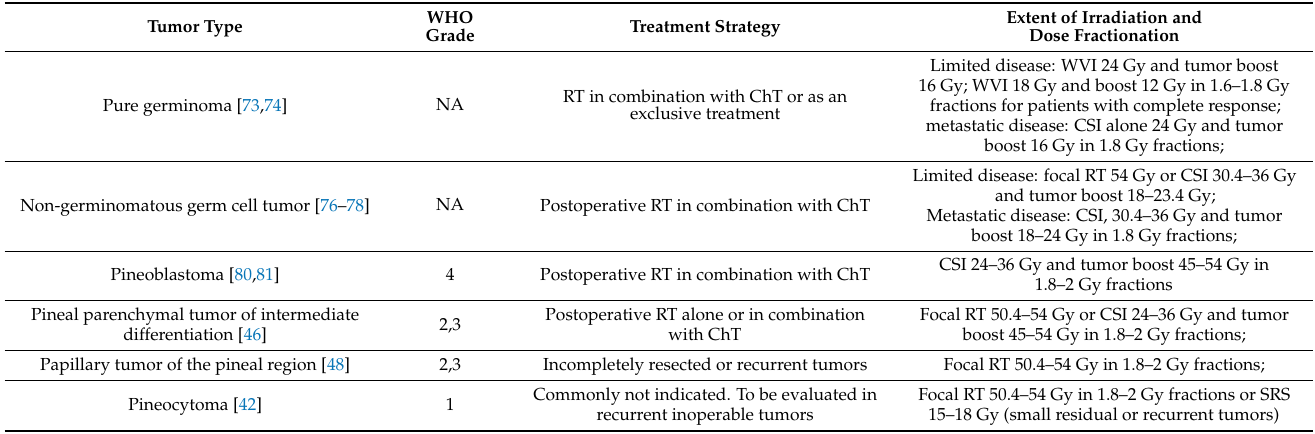
Table 3. Radiation therapy for tumors of the pineal